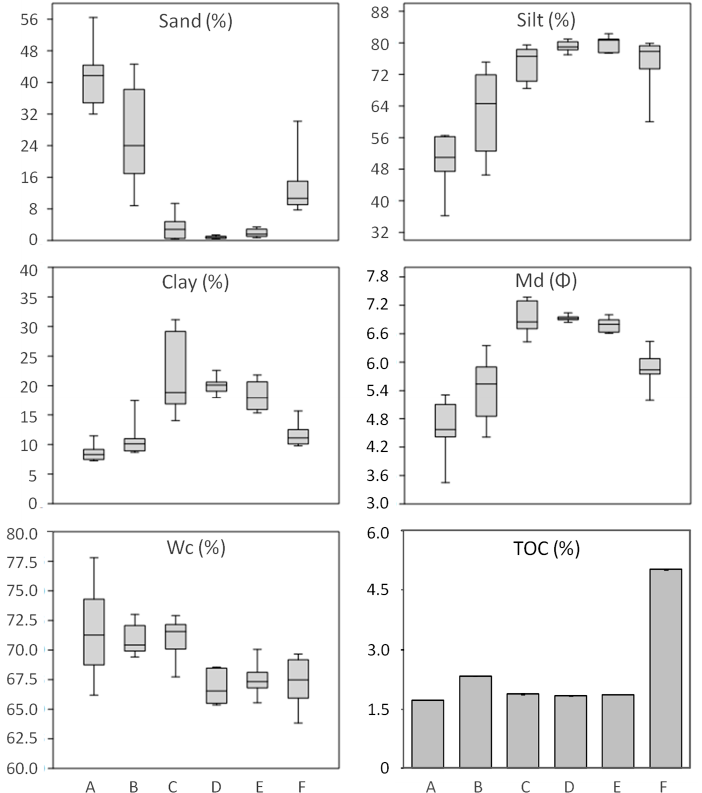
Figure 4. Box-plots of sediment sand, silt and clay content, and median particle diameter (Md) and water content (Wc) at each site (n = 9), as well as the mean value of total organic carbon (TOC) content of sediments at each site (n = 3, ±SE standard error not visible when <0.01). Water 2019 , 11 , x FOR PEER REVIEW